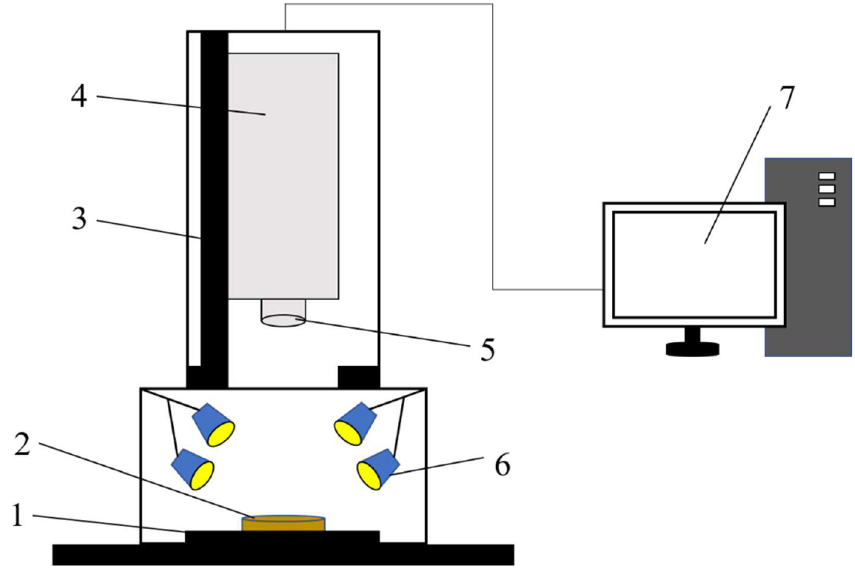
Figure 10. Schematic diagram of a hyperspectral imaging system. 1. Electronically controlled mobile platform; 2. Sample; 3. Camera lifting platform; 4. Hyperspectral imager; 5. Lens; 6. Light source; 7. Computer.